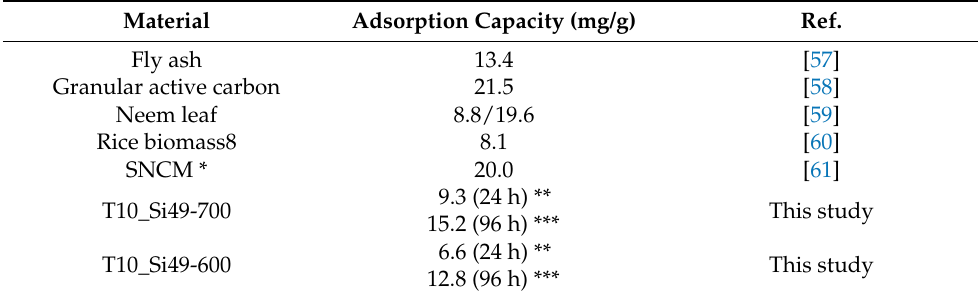
Table 1. Adsorption capacity of MB on different